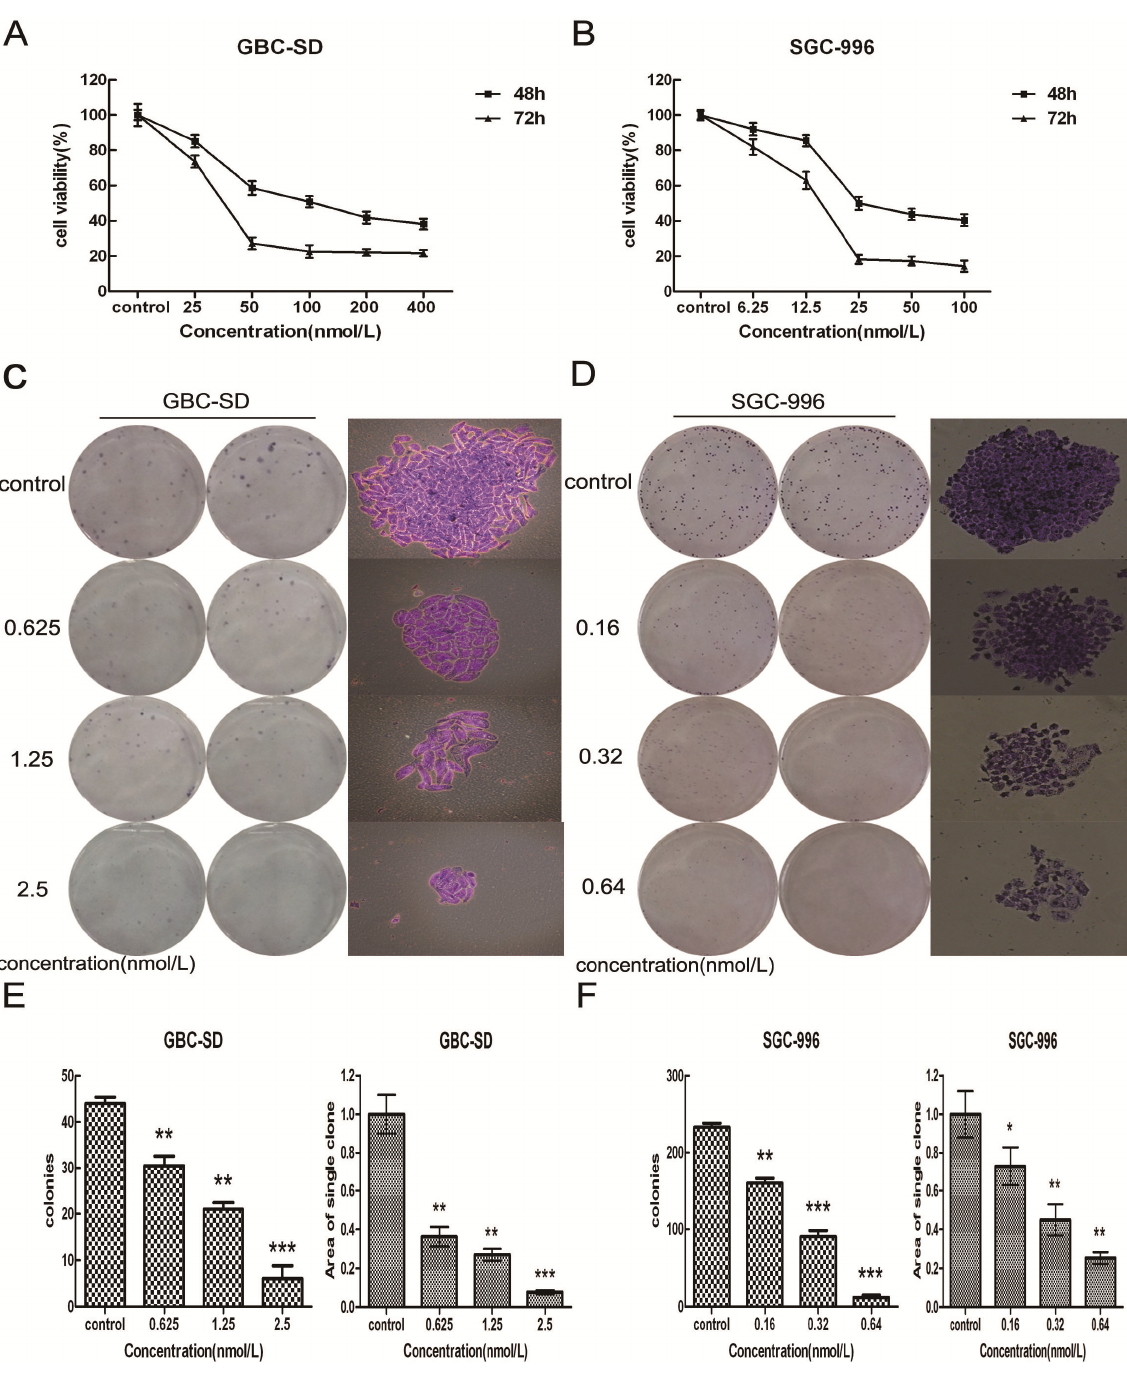
Figure 2. Triptolide dose-dependently decreases proliferation and viability of gallbladder cancer cells. (A) GBC-SD cells and ( B) SGC-996 cells were treated with different concentrations of triptolide for 48 and 72 h. Cell viability and IC50 were determined by MTT assay. C – F Triptolide suppressed colony formation of GBC-SD and SGC-996 cells. GBC-SD cells and SGC-996 cells were treated with triptolide for 48 h then cells were cultured in fresh medium for 14 days to form colonies. Representative Giemsa staining pictures of the colonies of GBC-SD cells ( C ) and SGC-996 cells ( D ). The number of the colonies of GBC-SD cells ( E ) and SGC-996 cells ( F ) were counted. Data shows the mean ± SD for three independent experiments. * p < 0.05; ** p < 0.01; *** p <